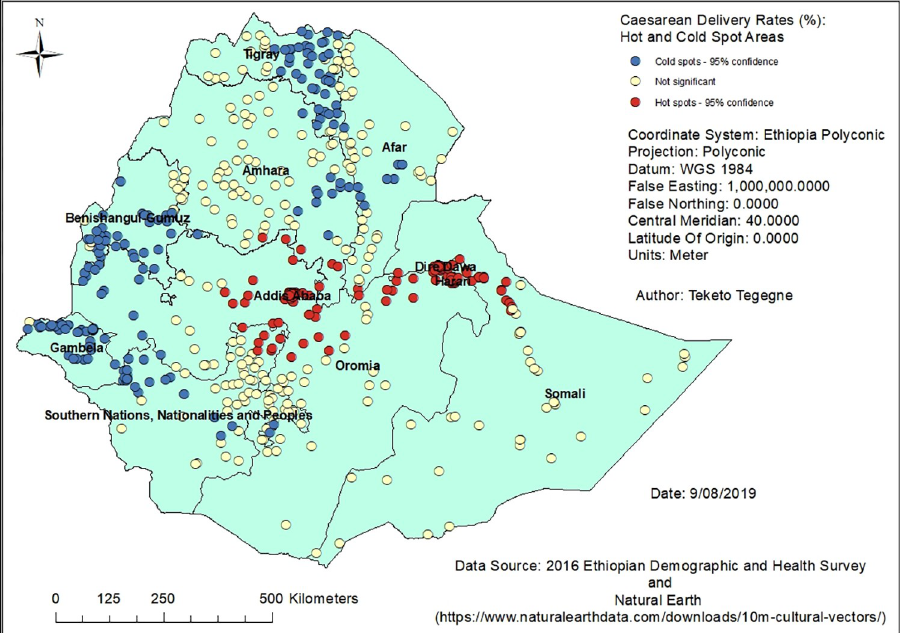
Fig 4. Clusters of high and low caesarean delivery rates in Ethiopia,